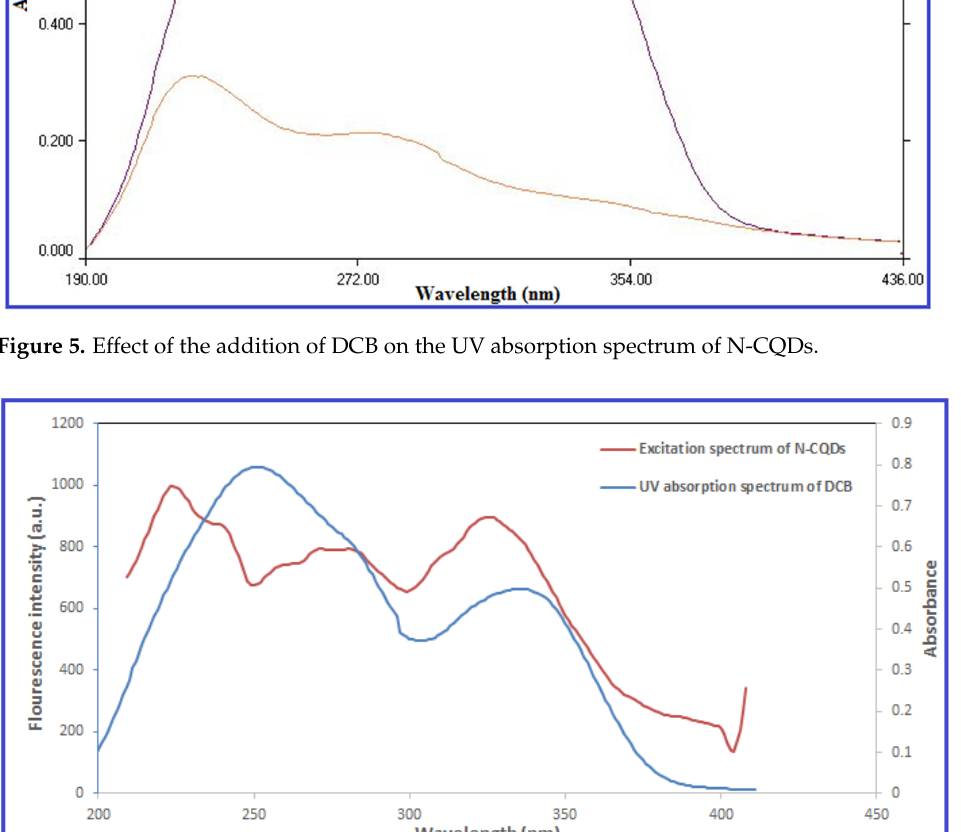
Figure 6. A co-plot of the excitation spectrum of the N-doped CQDs and the absorption spectrum of DCB (20.0 µg/mL).